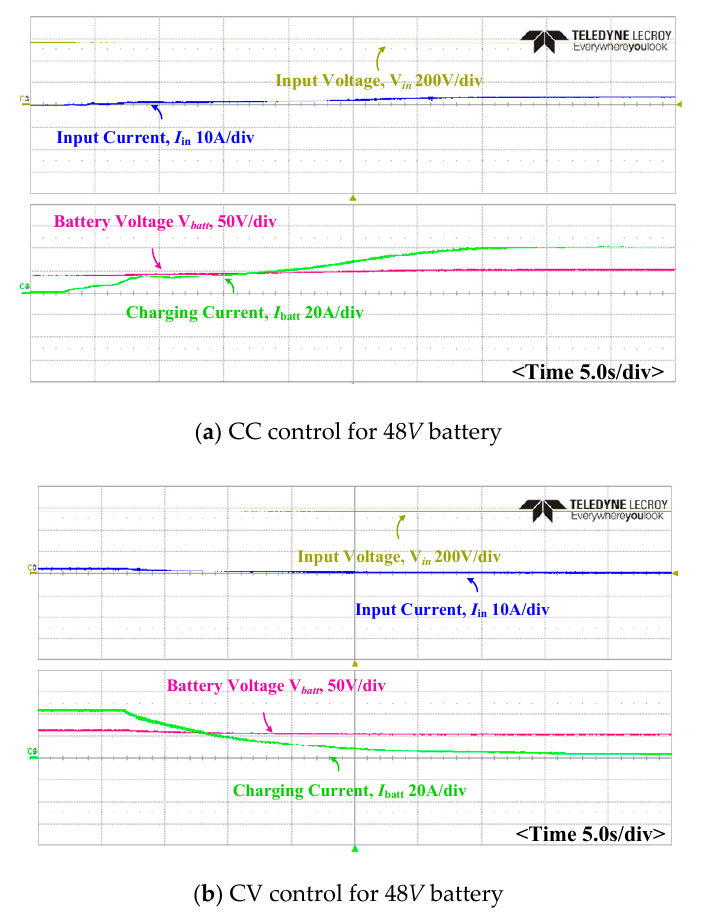
Figure 18. CC-CV control experimental results of Switching Pattern 1.